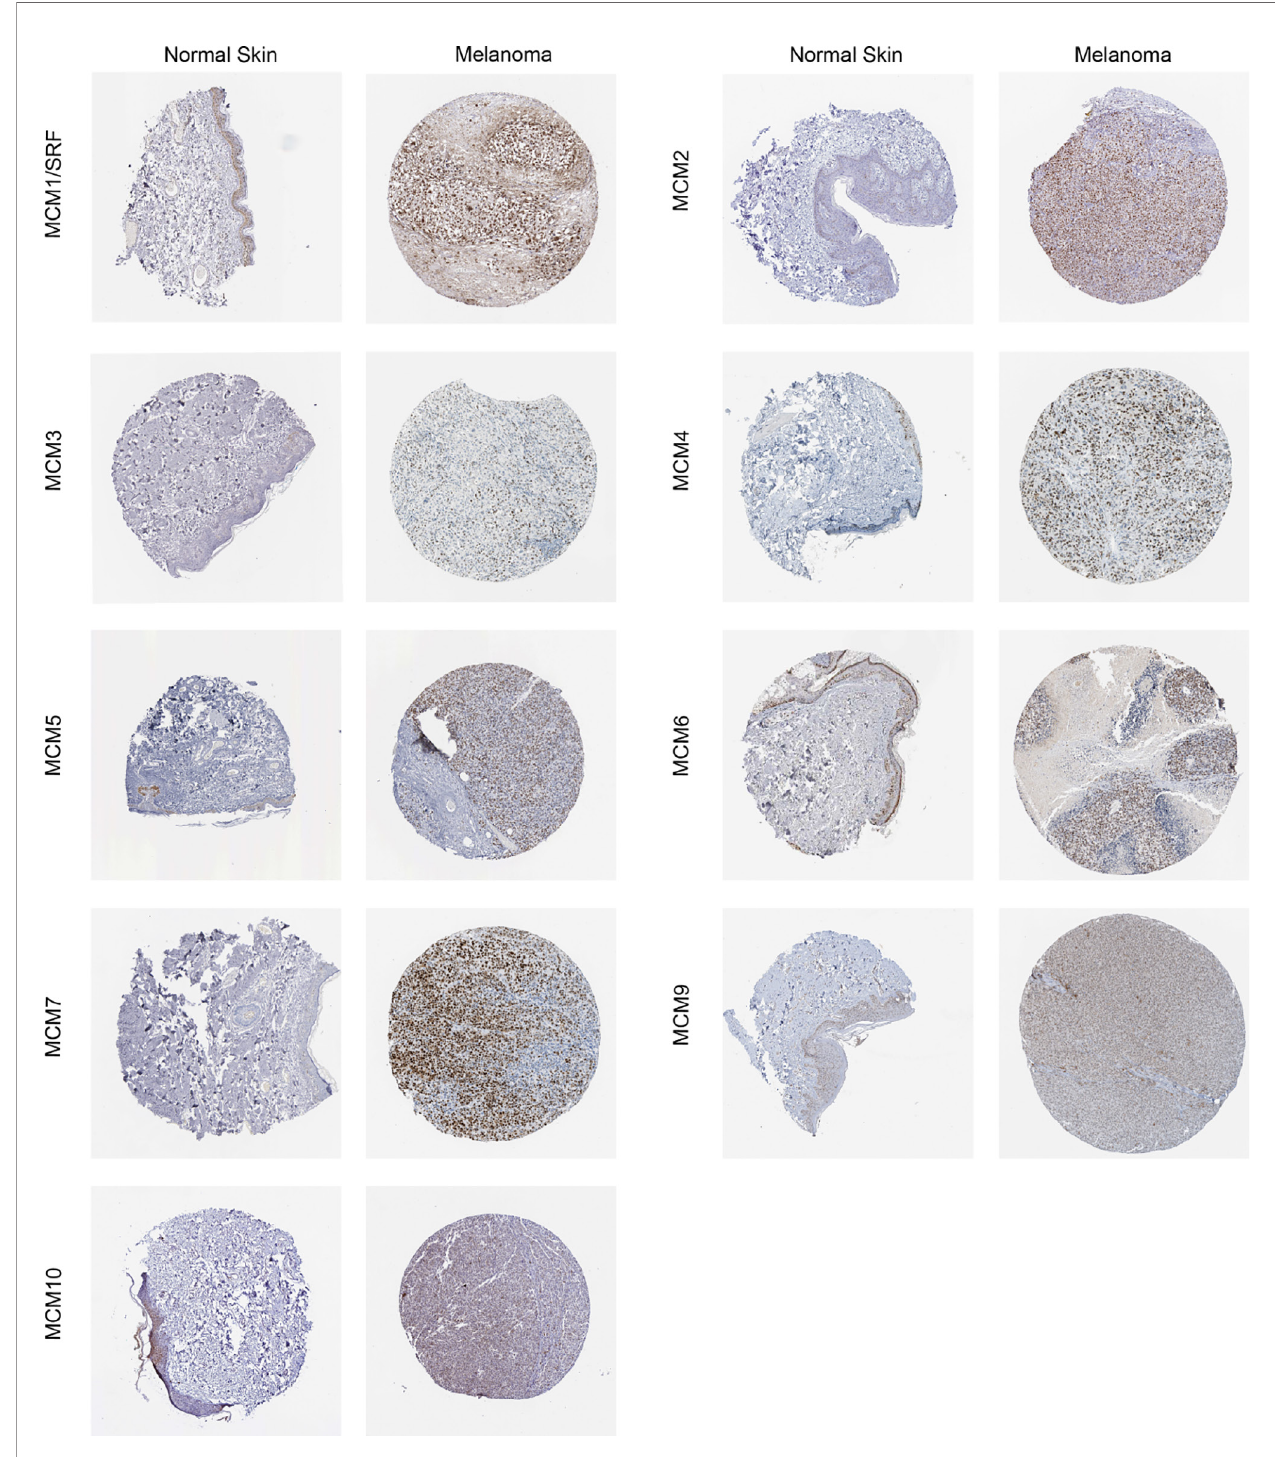
FIGURE 7 | Immunohistochemical staining for protein expression of MCM s in tissues from patients with SKCM and normal tissues. The results revealed MCM1 – 7 protein levels were higher in melanoma tissues than in normal skin tissues, consistent with the results of MCM mRNA expression, whereas MCM9 and MCM10 proteins showed no great difference between melanoma and normal